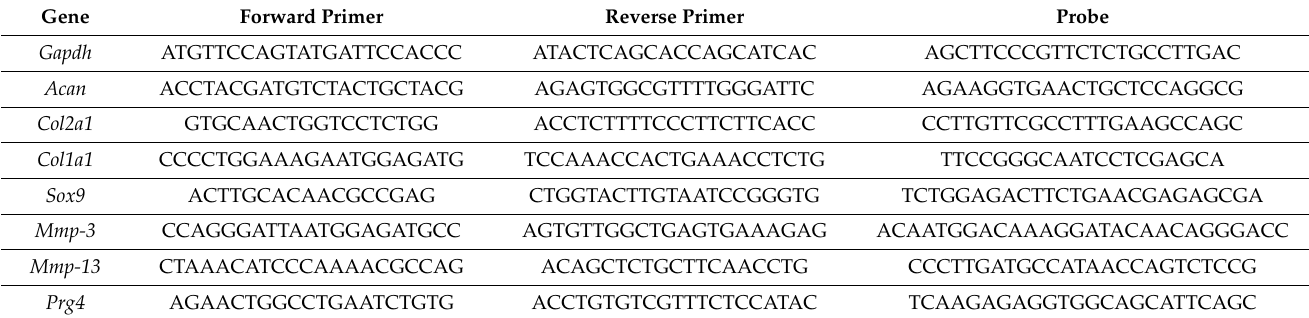
Table 4. List of sequences for primers and probes used during gene expression analysis (3 (cid:48) -5 (cid:48) ).